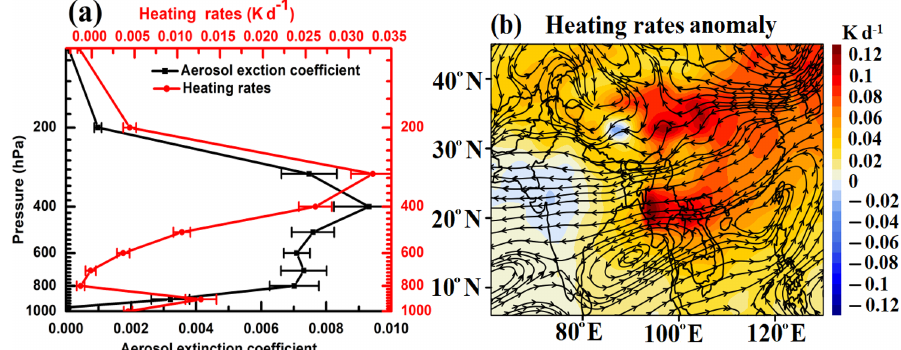
Figure 7. (a) Vertical profile of anomalies of extinction (km − 1 ) and heating rate (Kd − 1 ) over the Arctic region (65–85 ◦ N) from the ECHAM6–HAMMOZ simulations (BMaeroon − BMaerooff). The horizontal lines indicate the standard deviation within the 10 members of the different initial conditions; (b) spatial distribution of anomalies of heating rates (Kd − 1 ) (short and long waves together) averaged from the surface to the tropopause. Streamlines in Fig. 7b indicate wind anomalies at 500hPa (BMaeroon − BMaerooff).